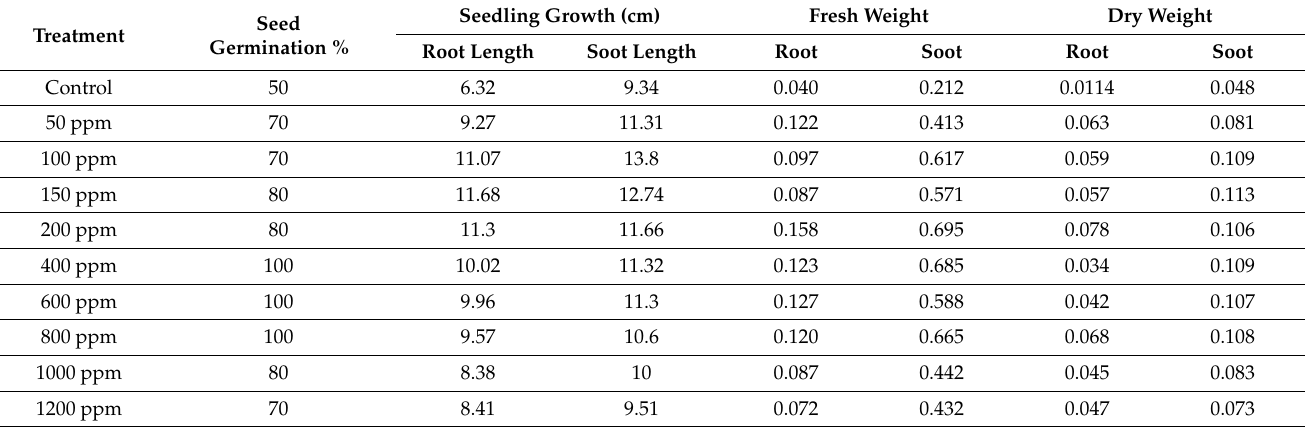
Table 3. Results for wheat